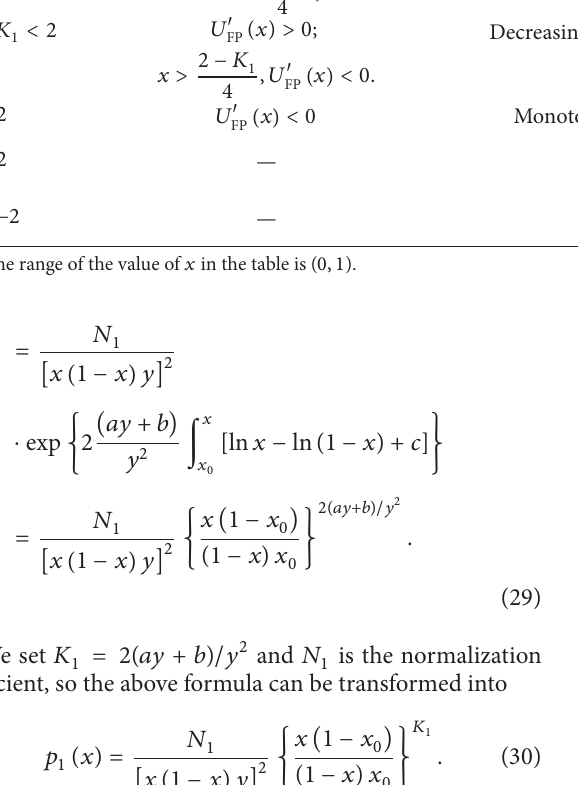
(𝑥) under different 𝐾 FP